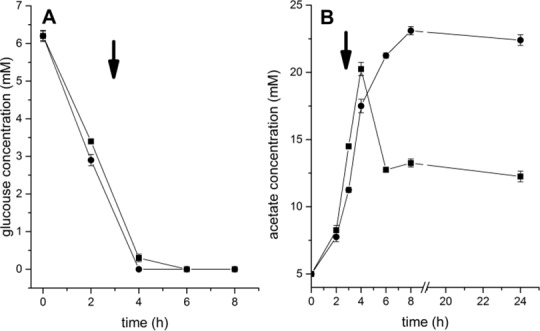
Glucose and acetate contents in the supernatants of growing S. aureus COL cultures.A) Consumption of glucose in the presence (●) and absence (■) of kendomycin. B) Accumulation/consumption of acetate in the presence (●) and absence (■) of kendomycin. Arrows indicate the addition of kendomycin. The data presented are the mean ± SD of three independent experiments.